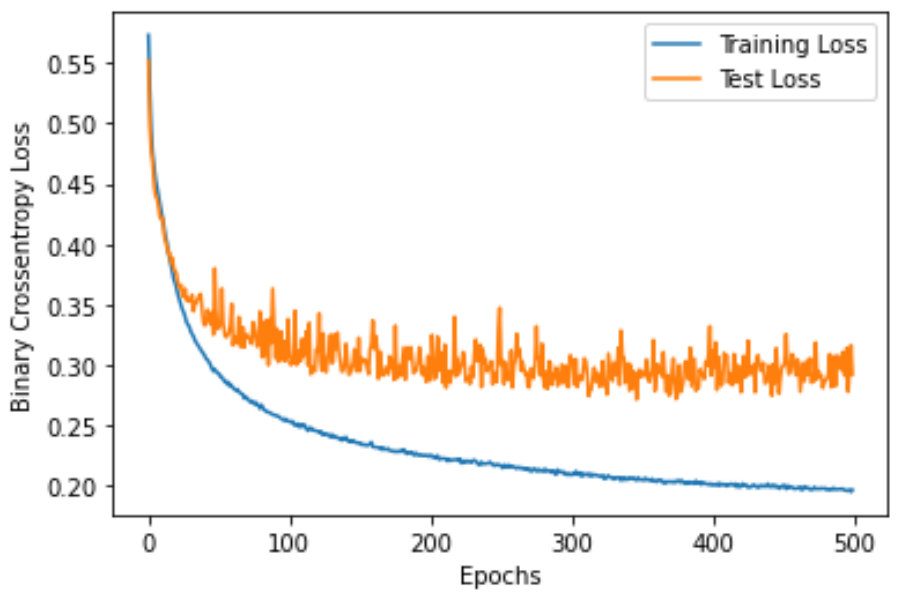
Figure 3. The loss curve for the EMG data classification of the left side using the proposed CNN architecture.